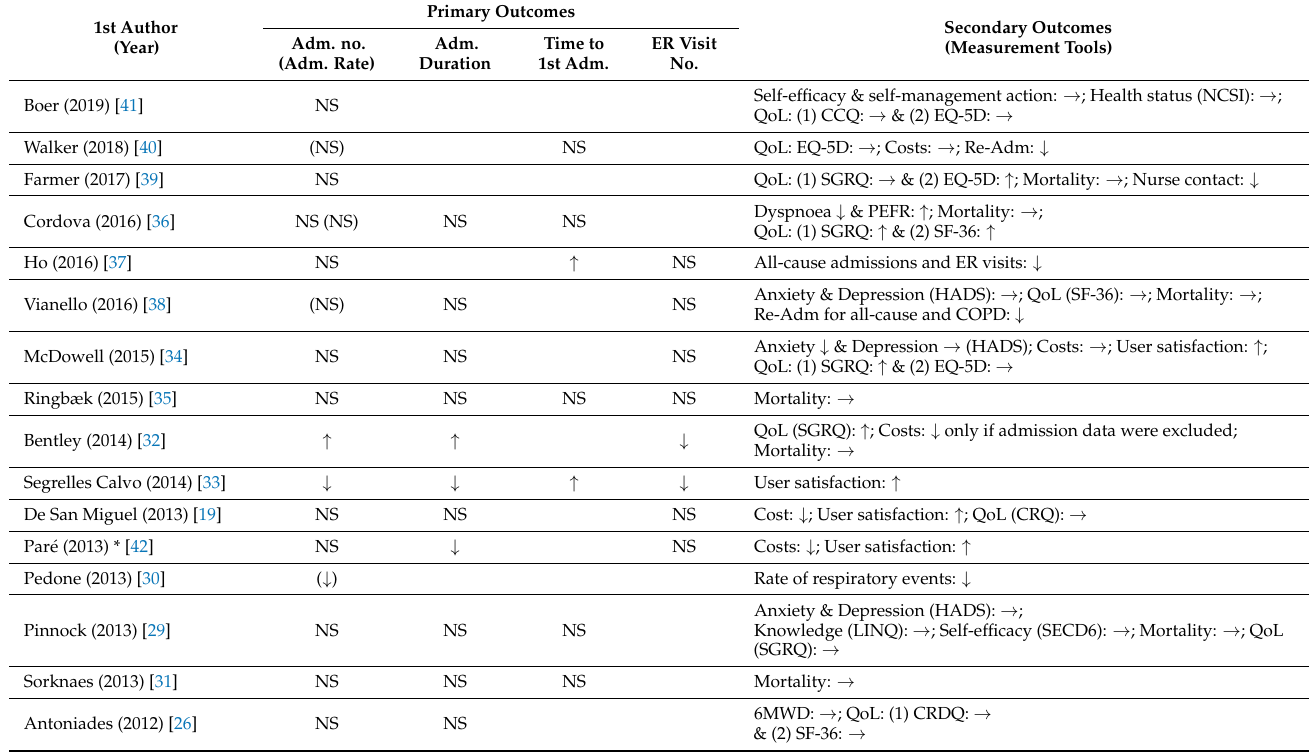
Table 2. Primary and secondary outcomes of telemonitoring